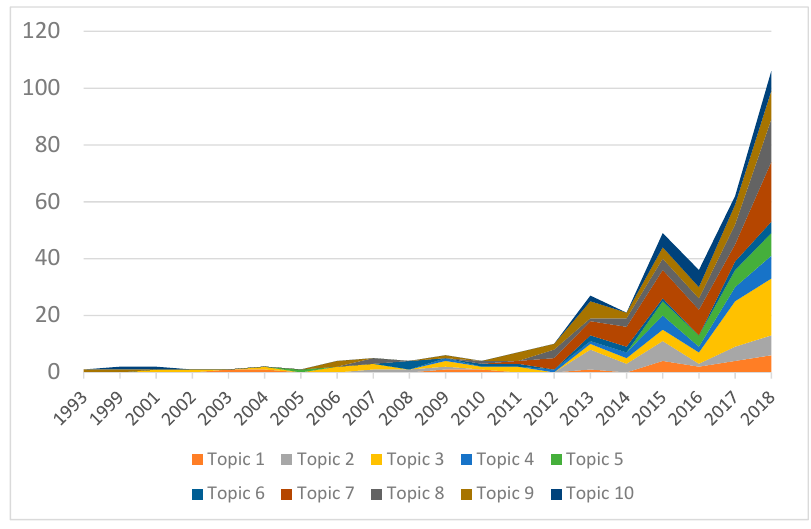
Figure 4. Changes in applications of AI to depression research during 1991–2018.